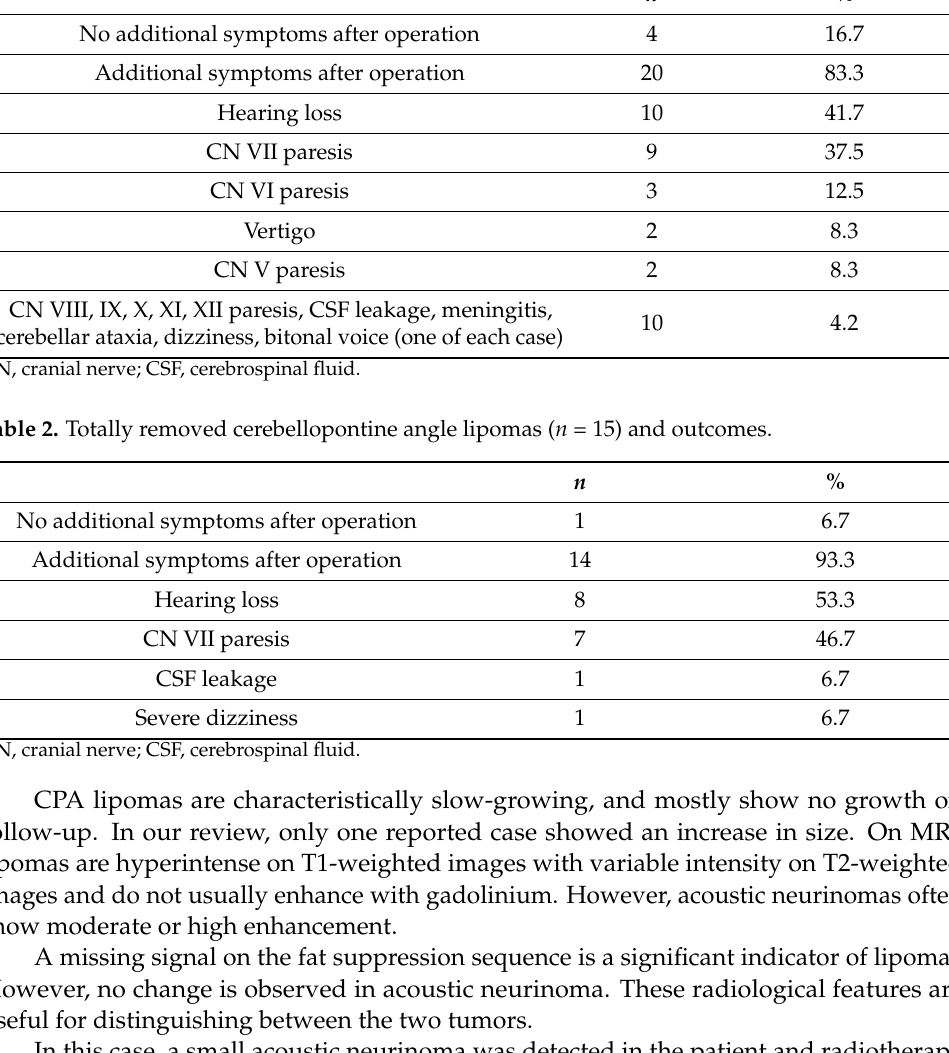
Table 1. Partially removed cerebellopontine angle lipomas ( n = 24) and outcomes. No additional symptoms after operation